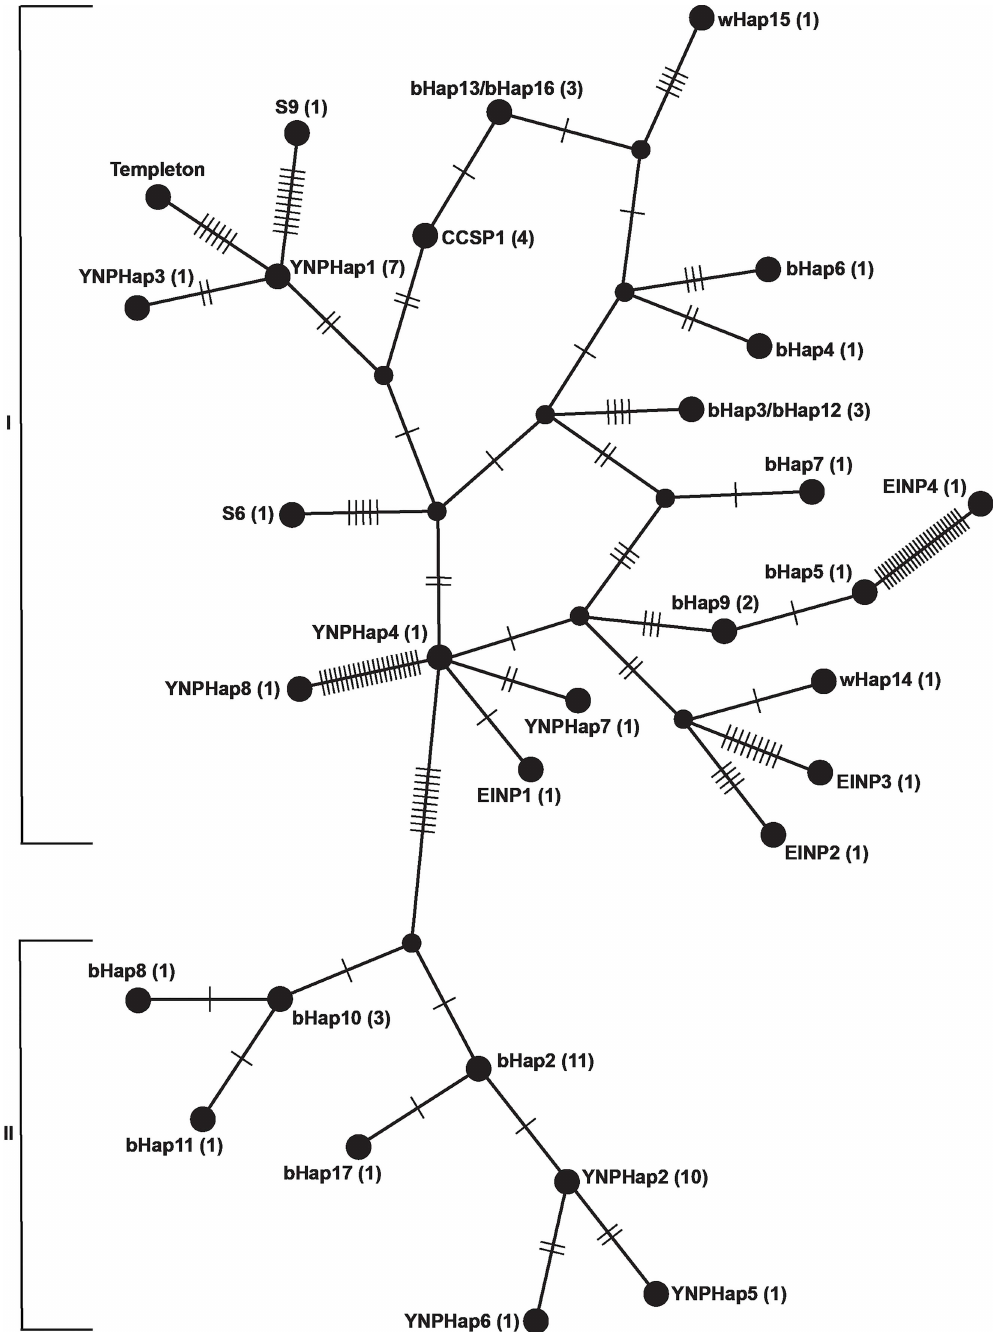
Fig 2. TCS network tree of North American bison, based on all polymorphic sites. Each dash represents one single nucleotide difference between two neighboring haplotypes. The numbersin the parenthesesafter the name of each haplotypedenotethe number of bison belongingto each haplotype.Roman numerals I and II represent the two clades in this analysis. Animalswith a wHap and EINP prefix denote wood bison haplotypes, whileYNPHap, Templeton, and bHap17denote Yellowstone bison. S6 and S9 are two historic bison sampledin or near the modern day Yellowstone NationalPark.